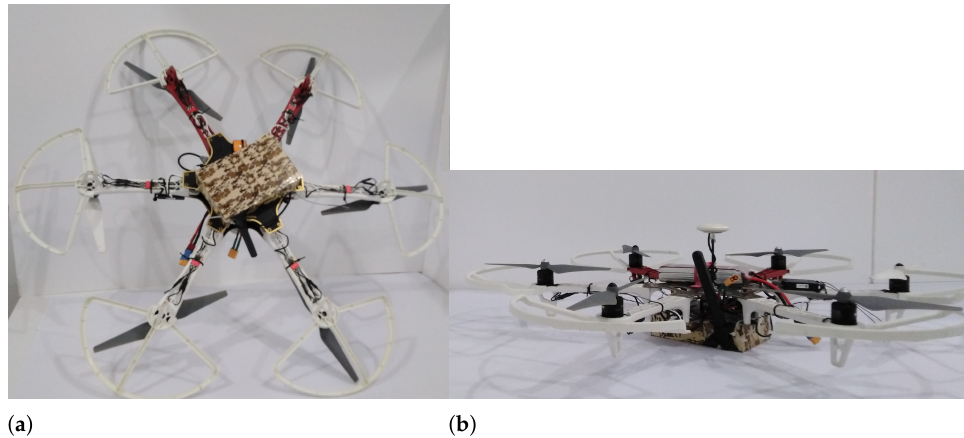
Figure 19. The UAV communication node mounted at the bottom of the DJI F550 Hex-rotor drone. ( a , b ) show the bottom and side views,